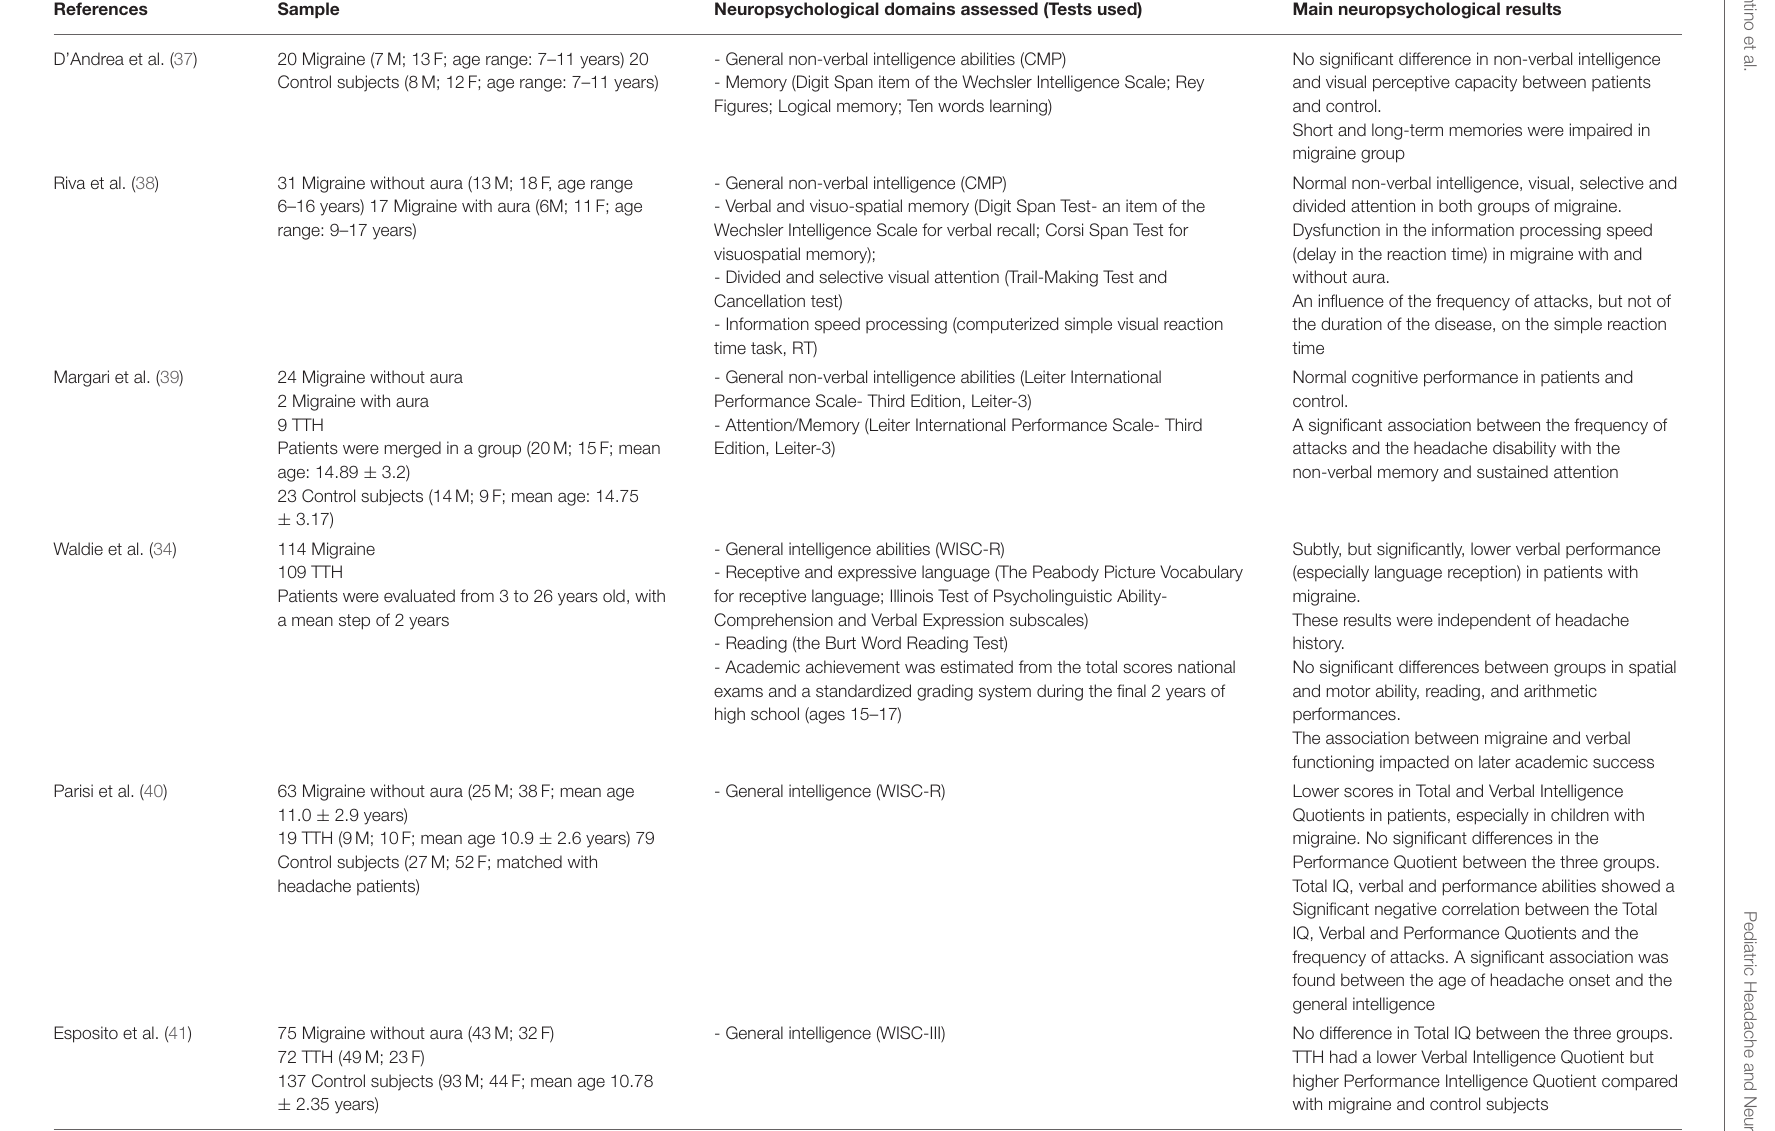
TABLE 1 | Summary of the results issued from the available